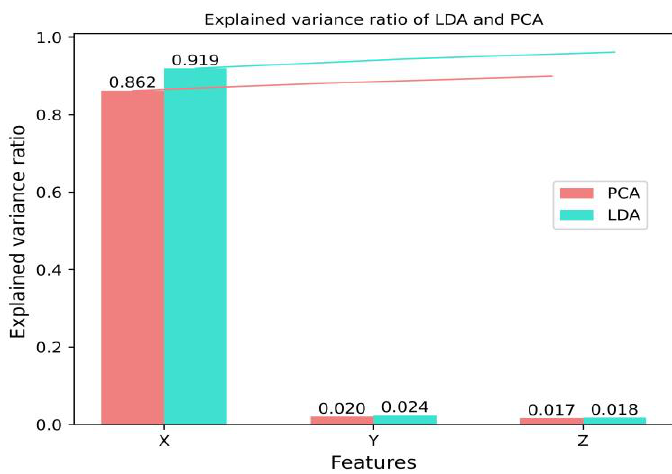
Figure 3. Explained variance ratio of LDA and PCA.